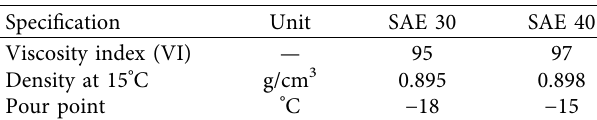
Table 3: Typical specifcation of diferent classes of engine oil according to the Society of Automotive Engineers (SAE) classifcation.